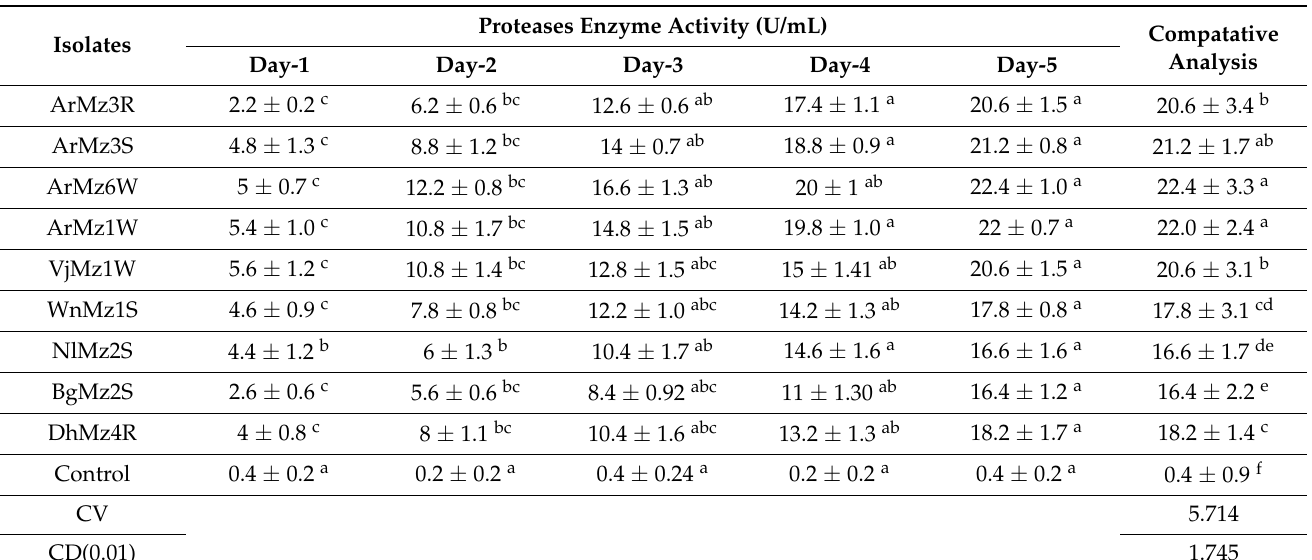
Table 3. Activities of protease (U/mL) (Mean ± SE) in the liquid culture media of the ento- mopathogenic fungi in the presence of H. puera